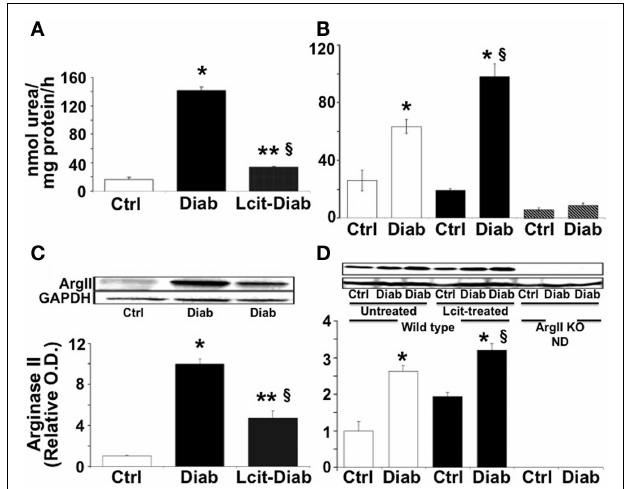
FIGURE 1 | Renal arginase . Kidney cortex isolated from mice after 2 (A–C) and 16 (B–D) weeks of diabetes was homogenized in lysis buffer. Arginase activity (A,B) was assayed using a colorimetric determination of urea production from L -arginine. Relative levels of arginase II protein expression (C,D) were determined by western blot analysis. Ctrl, control; Diab, diabetic;WT, wild type; ArgII KO, ArgII knock out; ND, not detected. Values are expressed as mean ± SEM, n = 4–6. (A–C) * p < 0.001 vs. Ctrl, § p < 0.01 vs. Ctrl, ** p < 0.001 vs. Diab. (B–D) , UntreatedWT;